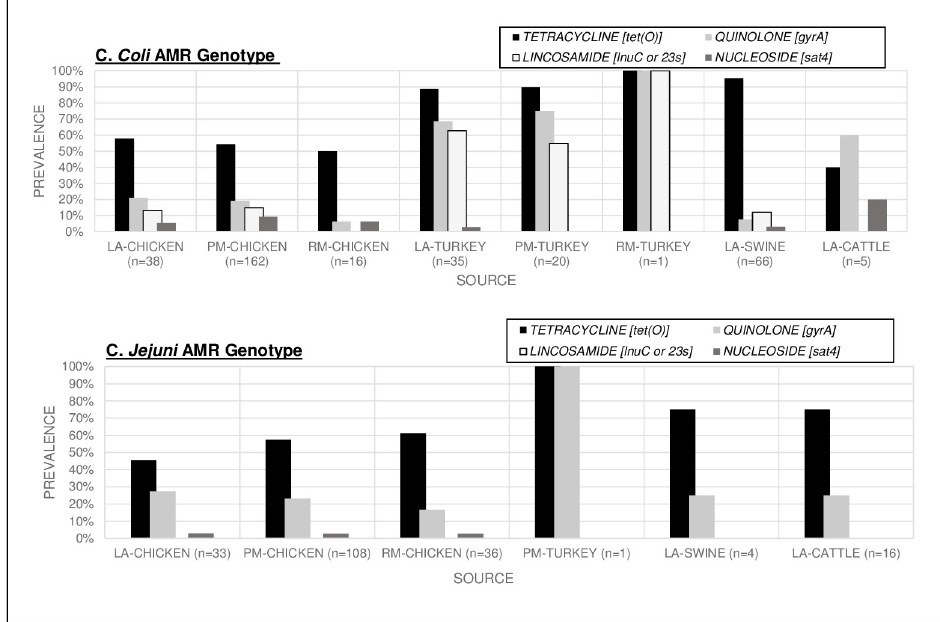
Fig 3. C . coli and C . jejuni AMR gene prevalence by source conferring resistance to tetracyclines, quinolones, lincosamides, and nucleosides. Chart coding: Live Animal (LA), Processed Meat (PM), Retail Meat (RM).